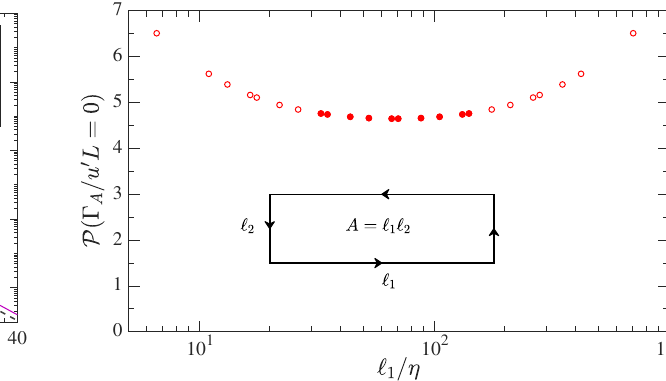
FIG. 14. Probability density function of circulation, normalized by its standard deviation, on a 4096 3 grid at R λ ¼ 650 , calculated using [Eq. (A1)] line integral of velocity (dashed lines) and [Eq. (A2)] surface integral of vorticity (solid lines), around square loops of size r . Different sets of curves correspond to, r= η ¼ 1 . 1 , 6.6, 41.8, and 125.4, increasing in the direction shown. Insets (a) and (b) compare the circulation moments from the two quad- ratures for orders 2 and 8,